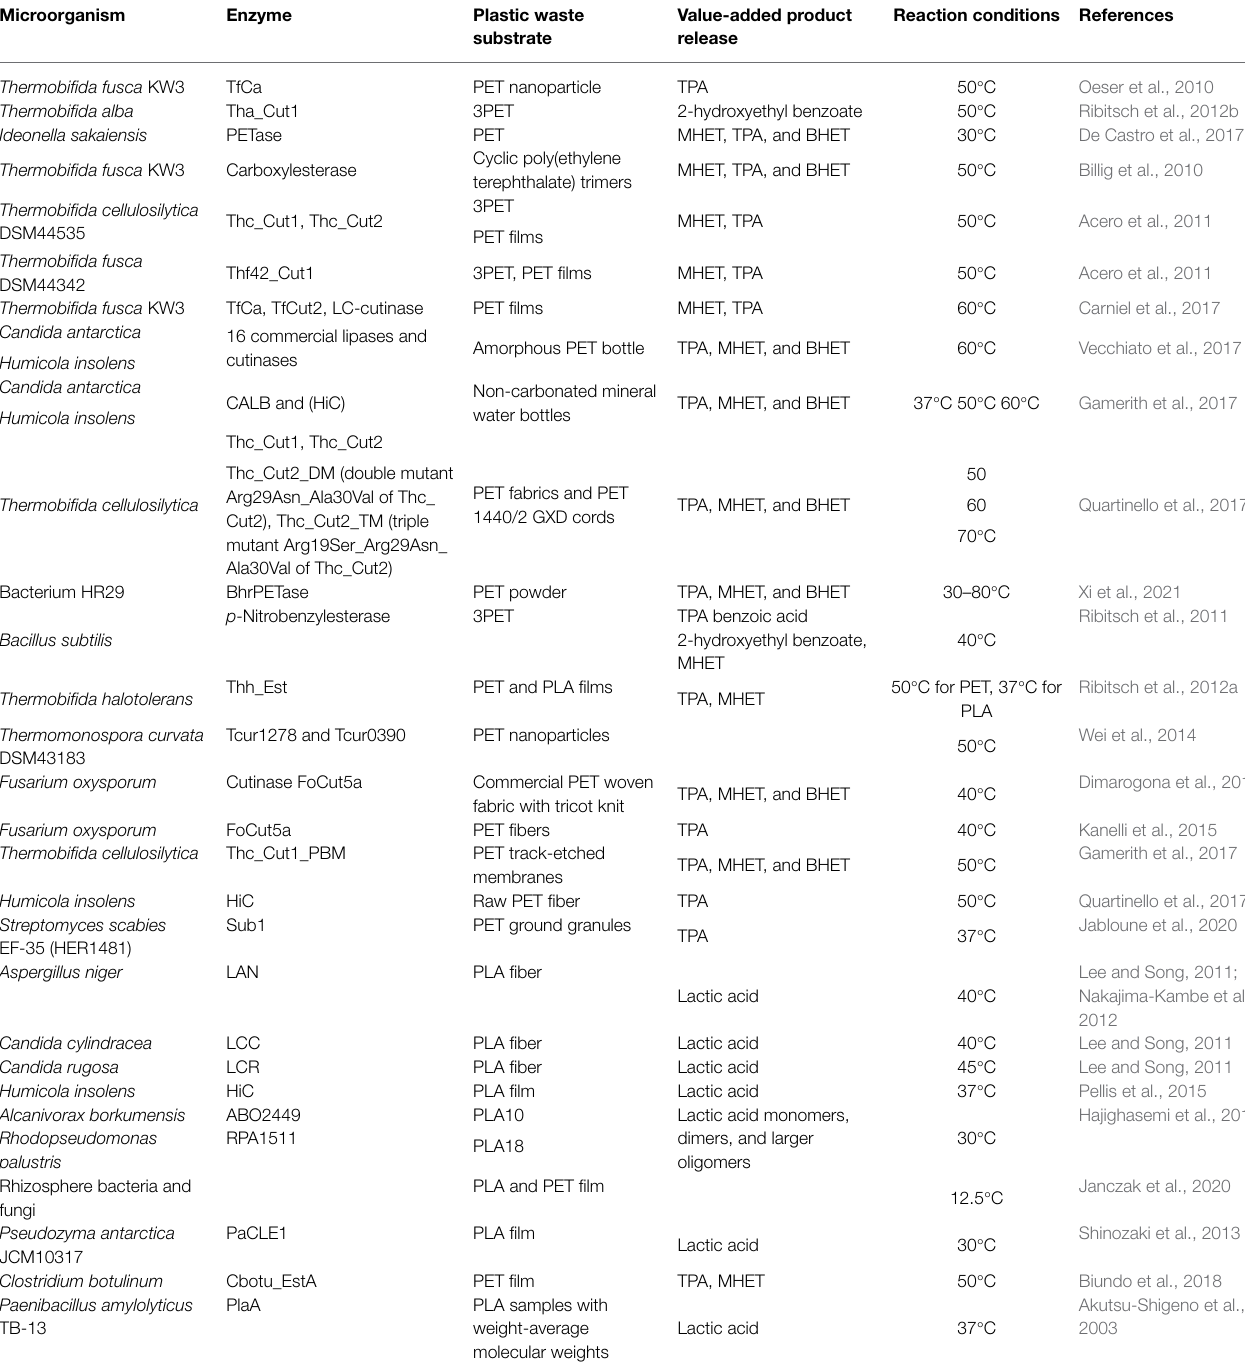
TABLE 2 | Summary of polylactic acid and polyethene terephthalate (PLA-PET) degrading enzymes, their microbial sources, and the value-added products released from the biodegradation process.